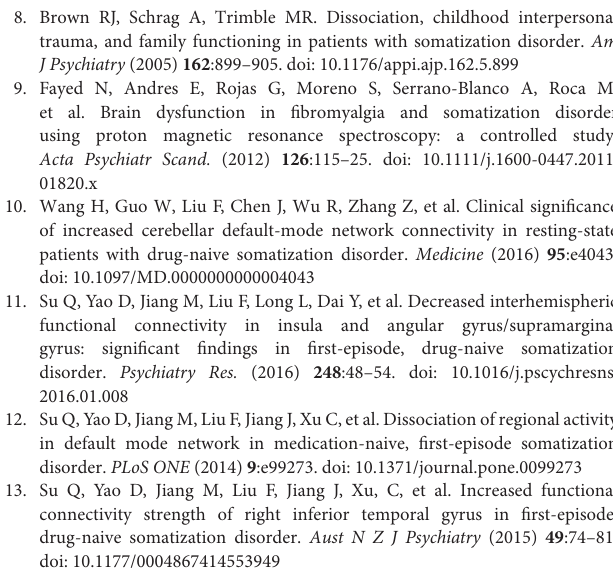
Supplementary Figure S2 | Voxel-wise Granger causality analyses in patients with somatization disorder: Whole-Brain-to-Seed